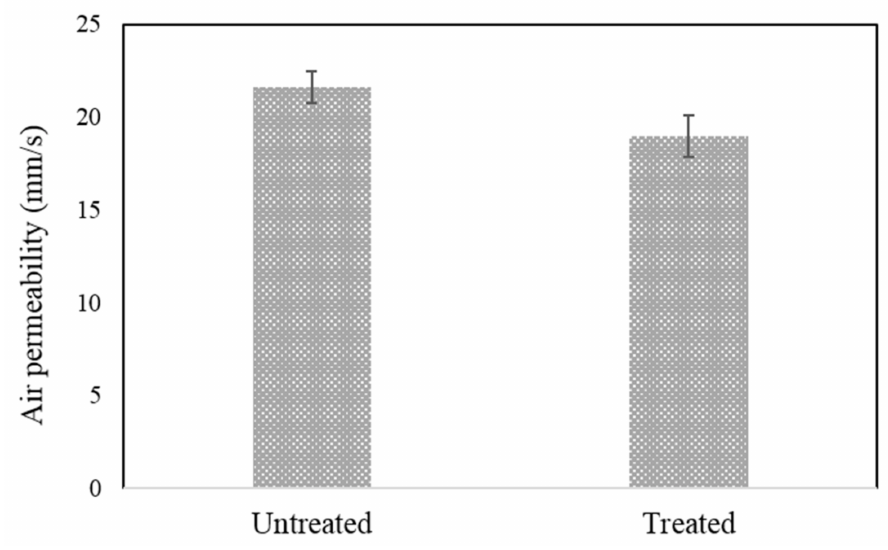
Figure 8. Air permeability of cotton